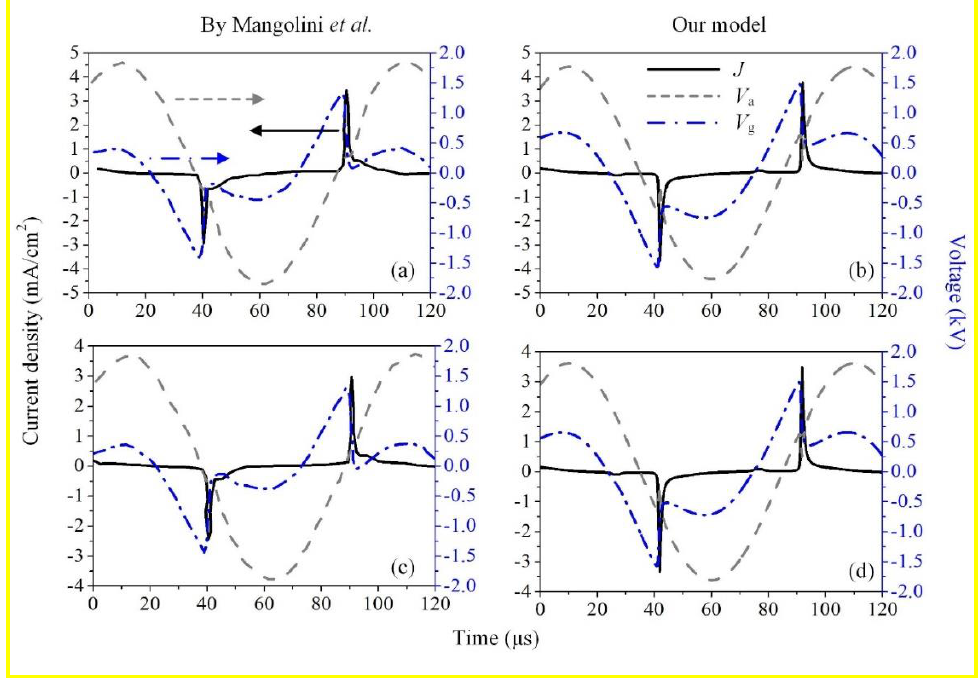
Figure 2. Comparison between ( a ) and ( c ) previous experimental waveforms and ( b ) and ( d ) their corresponding simulation results obtained from our model under mostly the same conditions. J , V a , and V g respectively denote the total discharge current density, applied voltage, and gap voltage. The experiment was assumed to have 100 ppm nitrogen impurities, whereas our simulation considers the pure helium. The main external parameters in ( a ) and ( b ) are: V am = 1776 V, f = 10 kHz, d g = 5 mm, d b = 1 mm; in ( c ) and ( d ) are: V am = 1813 V, f = 10 kHz, d g = 5 mm, d b = 1.5 mm .